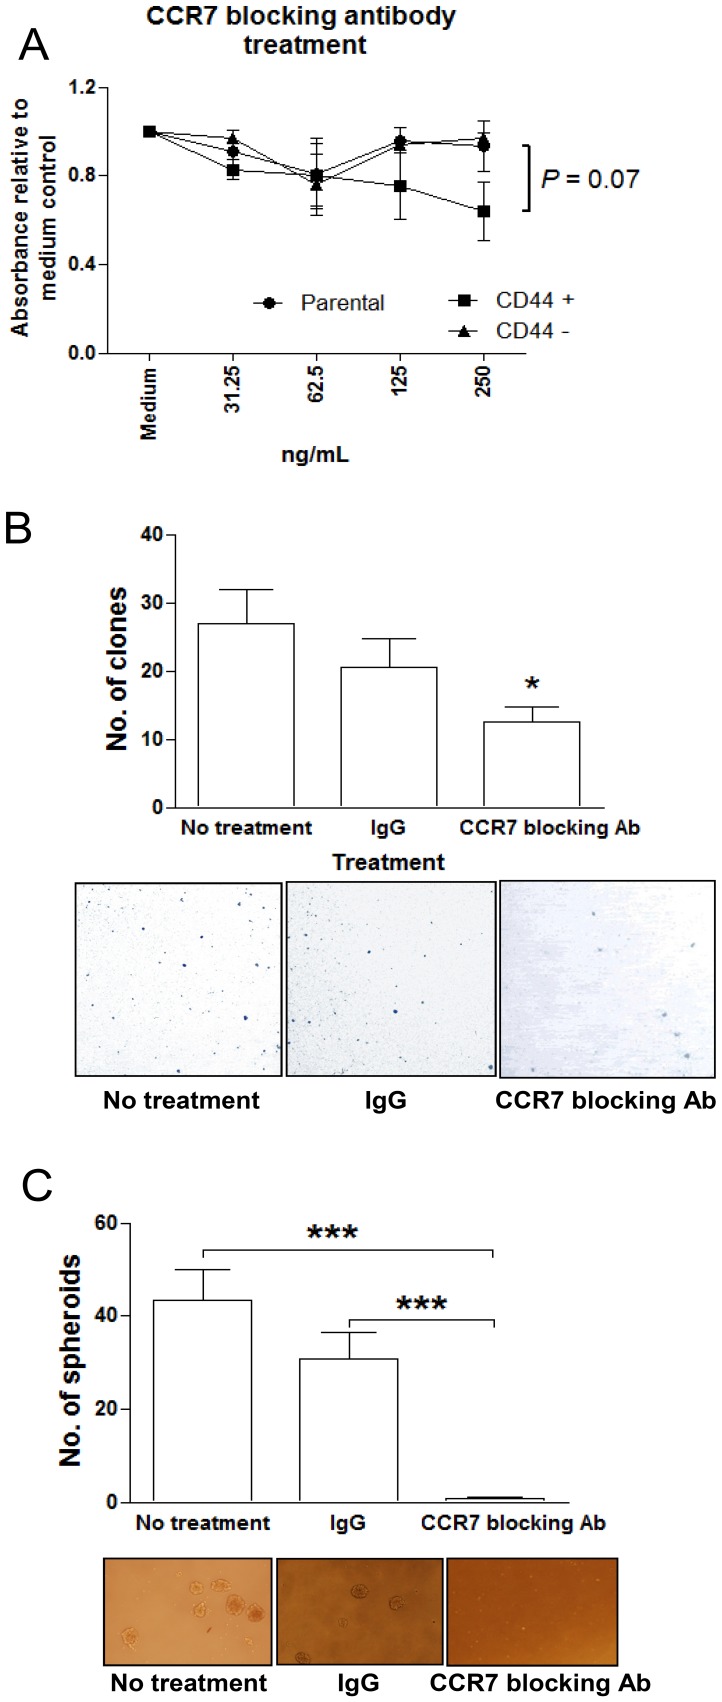
Effect of CCR7 neutralization on NPC CSCs.To evaluate the function of CCR7 in CSCs, C666-1 was treated with CCR7 blocking antibody and its proliferation, clone-forming and sphere-forming efficiency were investigated. (A) Proliferation of CD44+ cells was inhibited after treatment with CCR7 blocking antibody. (B) The clone formation efficiency of C666-1 cells was diminished after CCR7 blocking and (C) the spheroid-forming ability was significantly inihibited (P<0.001) when compared to untreated controls. Histograms denoting mean ± SE (n≥3) with statistical significance calculated by t-test (*P<0.05, ***P<0.001).